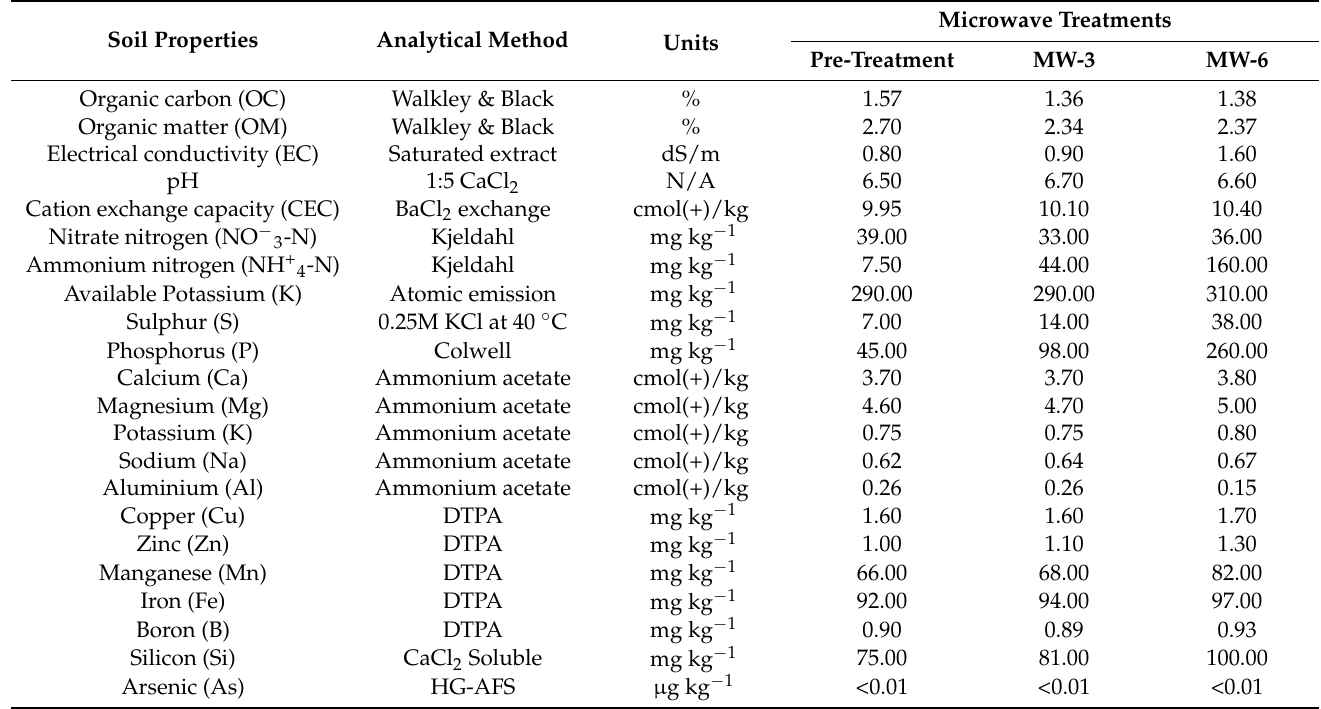
Table 1. Physicochemical properties of pre and post microwave (MW) treated soils before